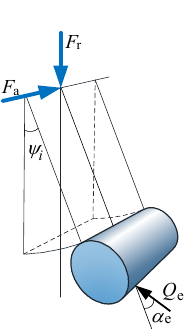
Figure 11. Spatial relationship between roller force and bearing forces.